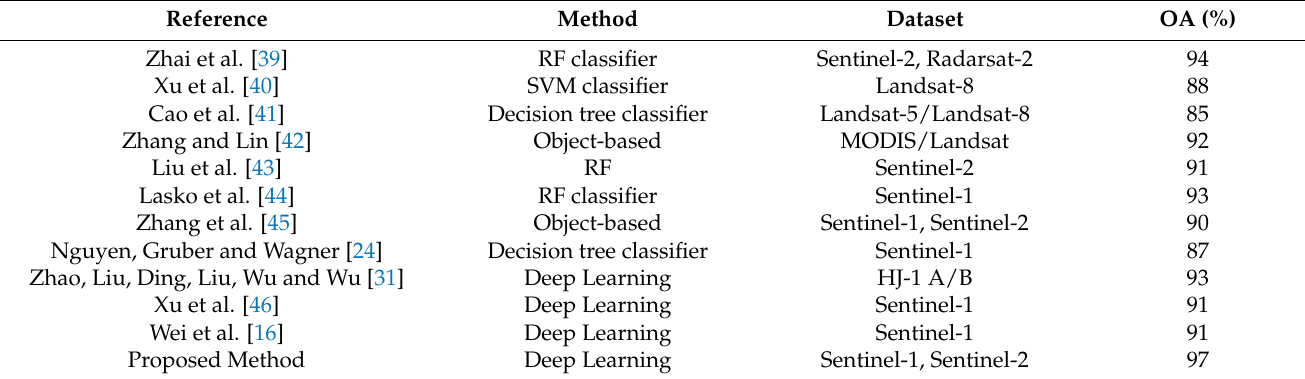
Table 5. The comparison of numerical results from rice-type mapping is based on multisource remote sensing